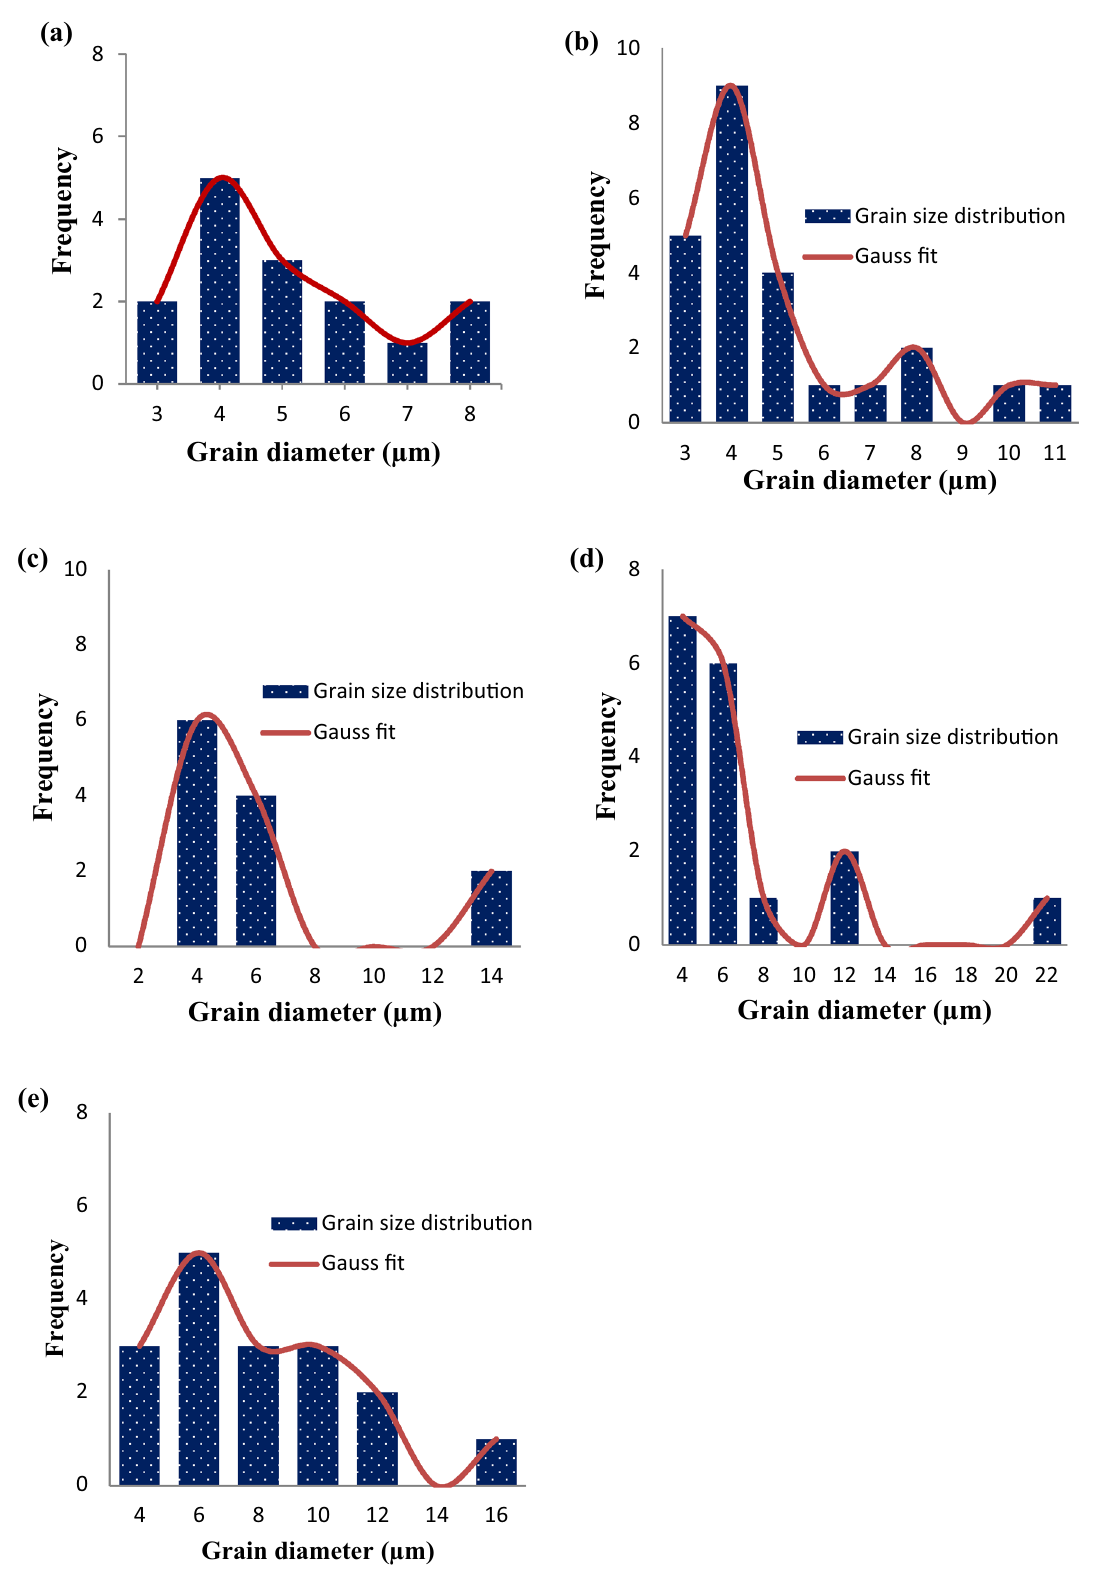
Fig. 6 Grain size distribution in silicon bronzes a Cu–3Si, b Cu–3Si–0.1Zn, c Cu–3Si–0.5Zn, d Cu–3Si–0.8Zn, and e